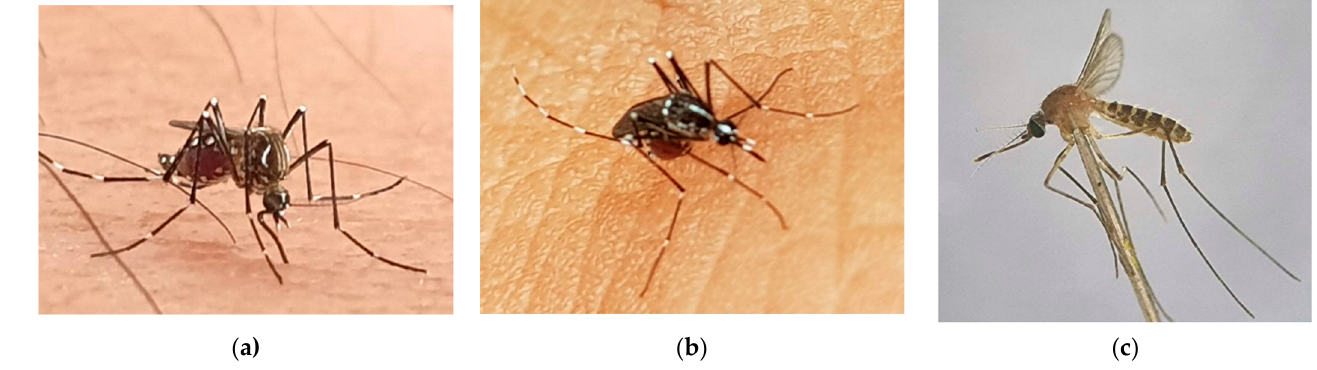
Figure 4. Photographs of three mosquito species which are potential vectors of several viruses, including dengue, Zika, and Japanese encephalitis in Vietnam: ( a ) Aedes aegypti ; ( b ) Aedes albopictus ; ( c ) Culex quinquefasciatus .